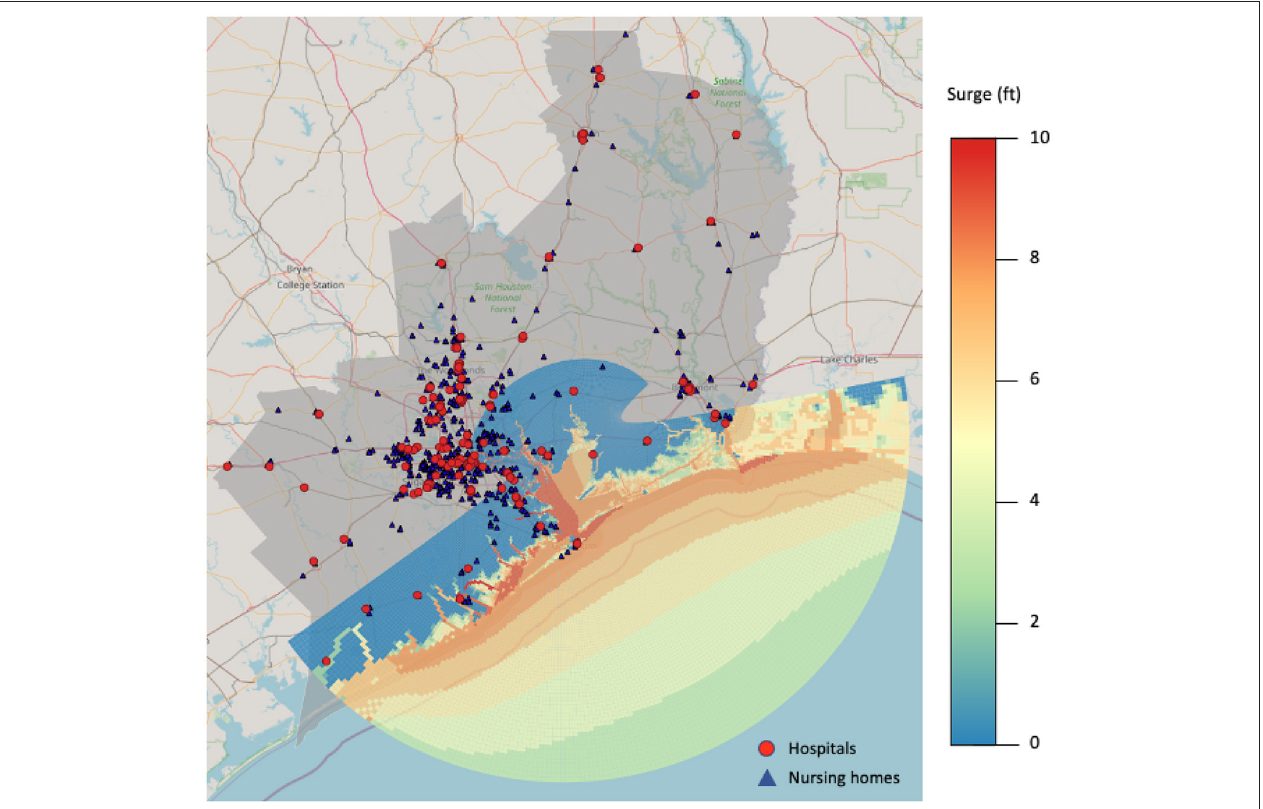
FIGURE 3 | Storm surge output from SDP generated with a Category 2 storm traveling in north direction with forward speed of 5 mph at high tide shows impact on the hospitals (red dots) and nursing homes (blue triangles) in our region of